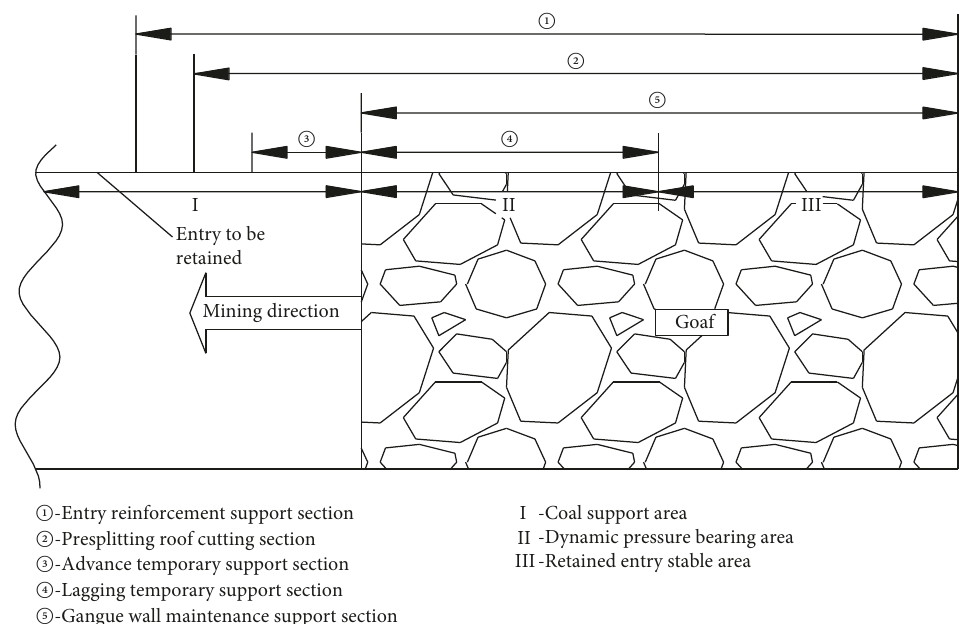
Figure 8: Process zoning map of Figure 8. (1) To avoid the influence of the roof presplitting